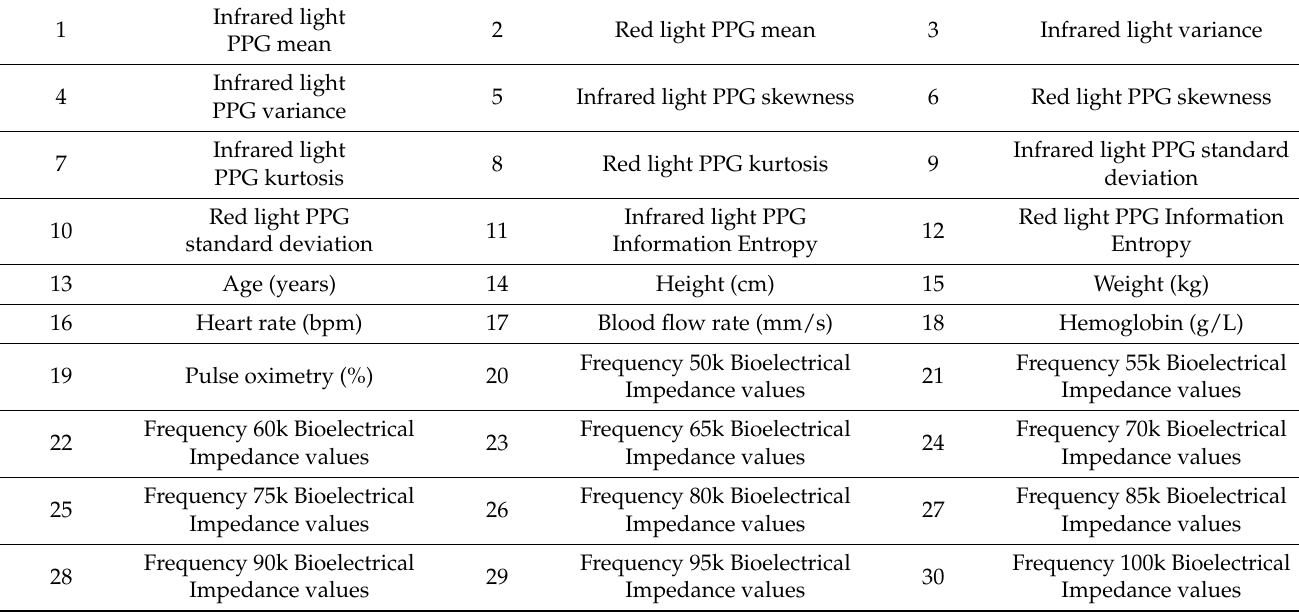
Table 2. Input characteristic values used by the BPNN.